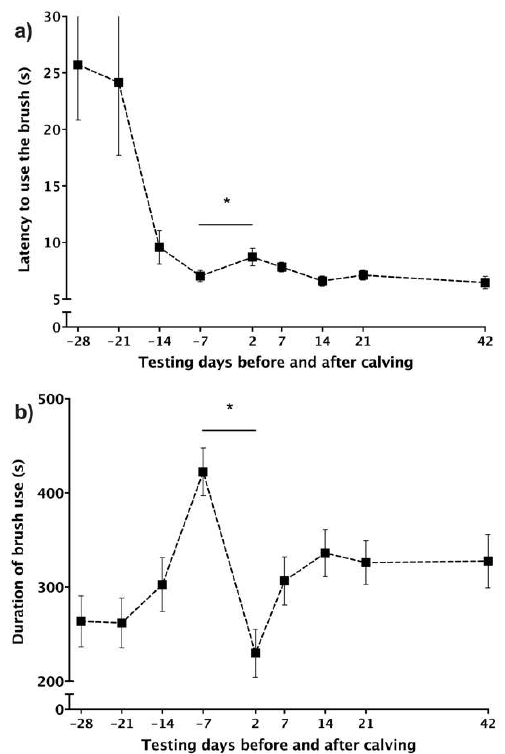
Figure 1. Parturition induces changes in brush use. ( a ) Latency to use the brush (mean ± SE) on days before and after calving ( n = 26). ( b ) Duration of brush use (mean ± SE) on days before and after calving in primiparous cows ( n = 26). Cows were progressively habituated to the testing routine potentially explaining the progressive decrease in latency and increase in brush use over the prepartum period. The baseline measures were obtained during the last brush test before calving. Data presented came from Experiment 1. An asterisk (*) represent a significant difference between day 7 and day 2.